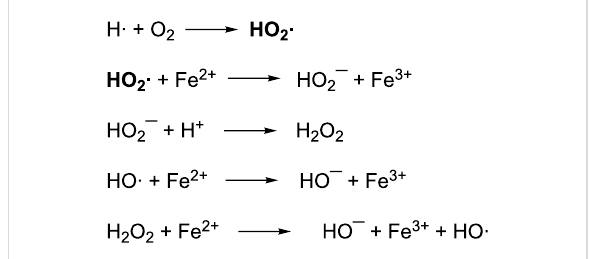
Scheme 1: Ionizing radiation reactions in the Fricke dosimeter.